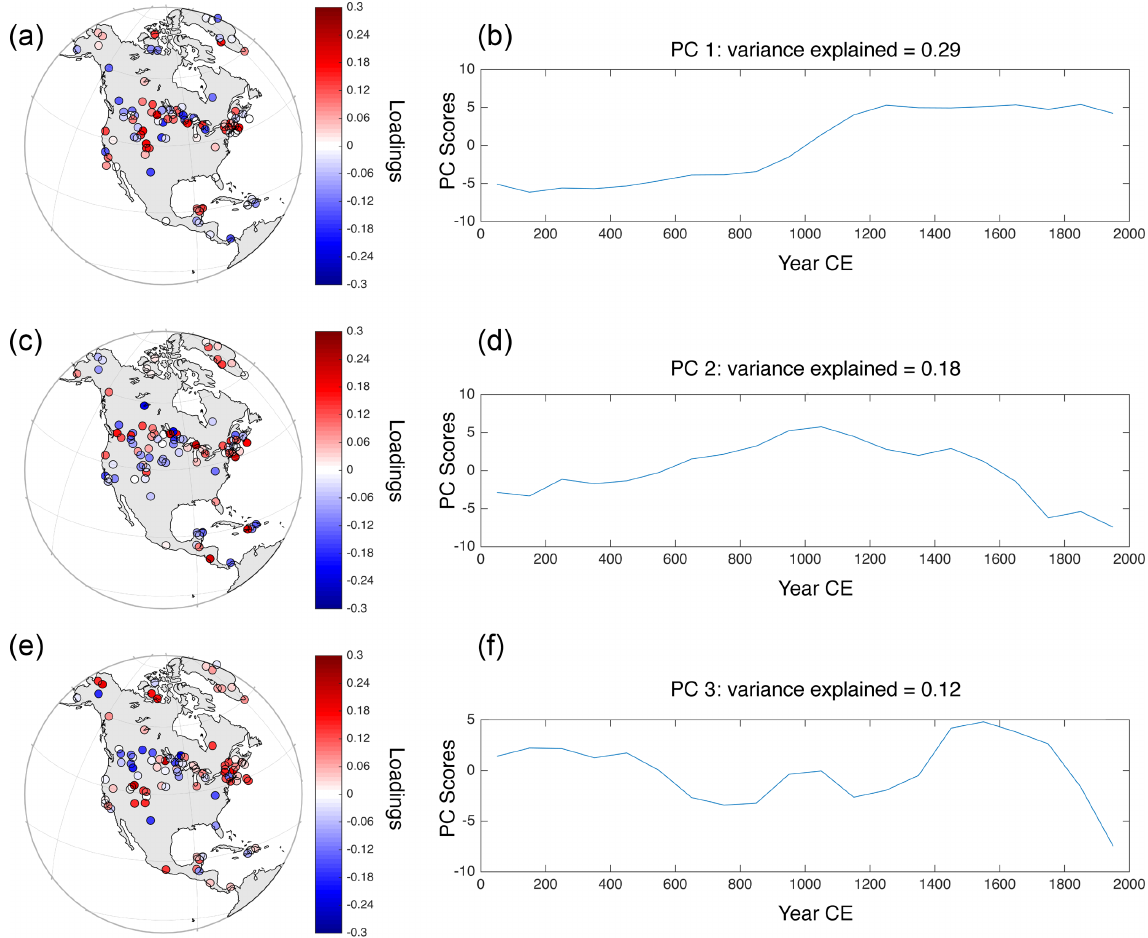
Figure 4. Results of empirical orthogonal function (EOF) analysis of the North American hydroclimate dataset showing (left) loadings associated with the first EOF, and (right) the average time series for each